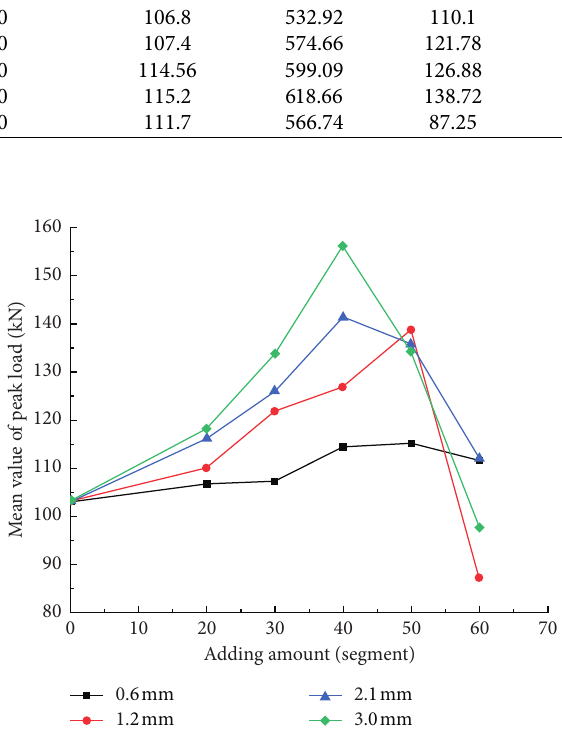
Figure 18: Effect of steel segment types and dosage on anchoring force.